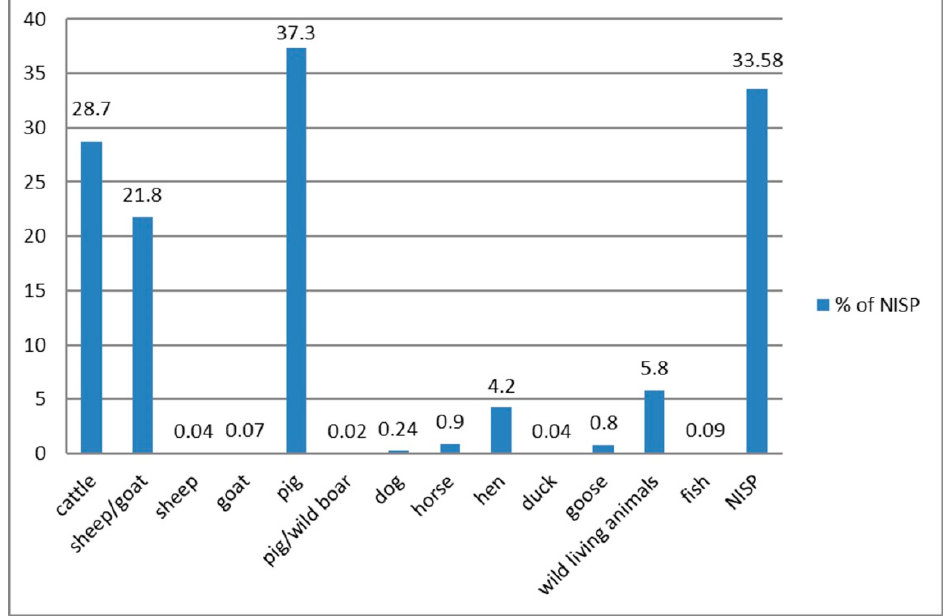
Figure 2. The frequency of the consumptive animal remains estimated on Wrocław Cathedral Island, ś w. Idziego (St. Giles) Street. NISP—number of identified specimens (NISP = 5568). The share of dog bones on the Cathedral Island ranged from 0.1% to 1.8% of NISP